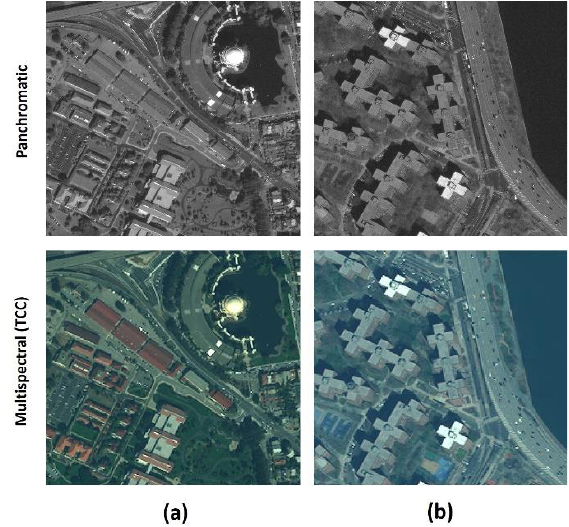
Figure 3. Presentation of datasets: (a) Resized PAN and MS image from San Francisco, (b) Resized PAN and MS image from NY